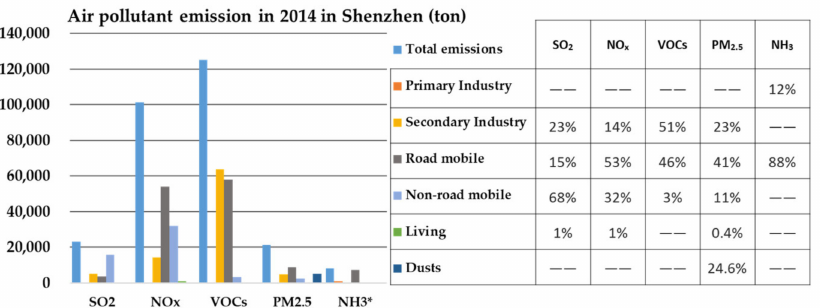
Figure 4. Estimated emissions in 2014, by sector. * Living emissions are taken from the China National Environmental Monitoring Centre (http://www.cnemc.cn/, accessed on 12 September